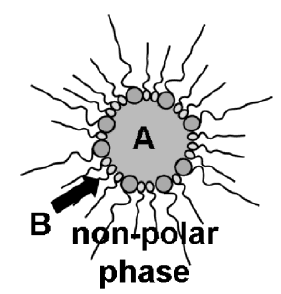
Figure 3. Synthesis of nanoscale hollow spheres via the microemulsion approach at the liquid-to-liquid phase boundary of a w/o -microemulsion due to a first reactant (A) inside the polar micellar phase and a second reactant (B) added to the non-polar dispersant